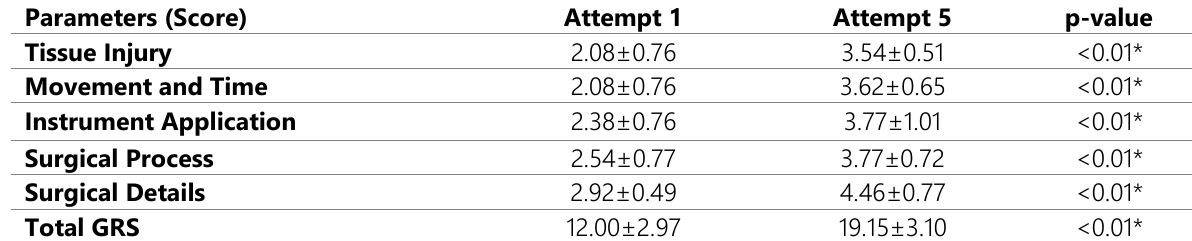
Table 4: TURP full procedure (Easy – 1), subjective assessment of trainees through GRS evaluation